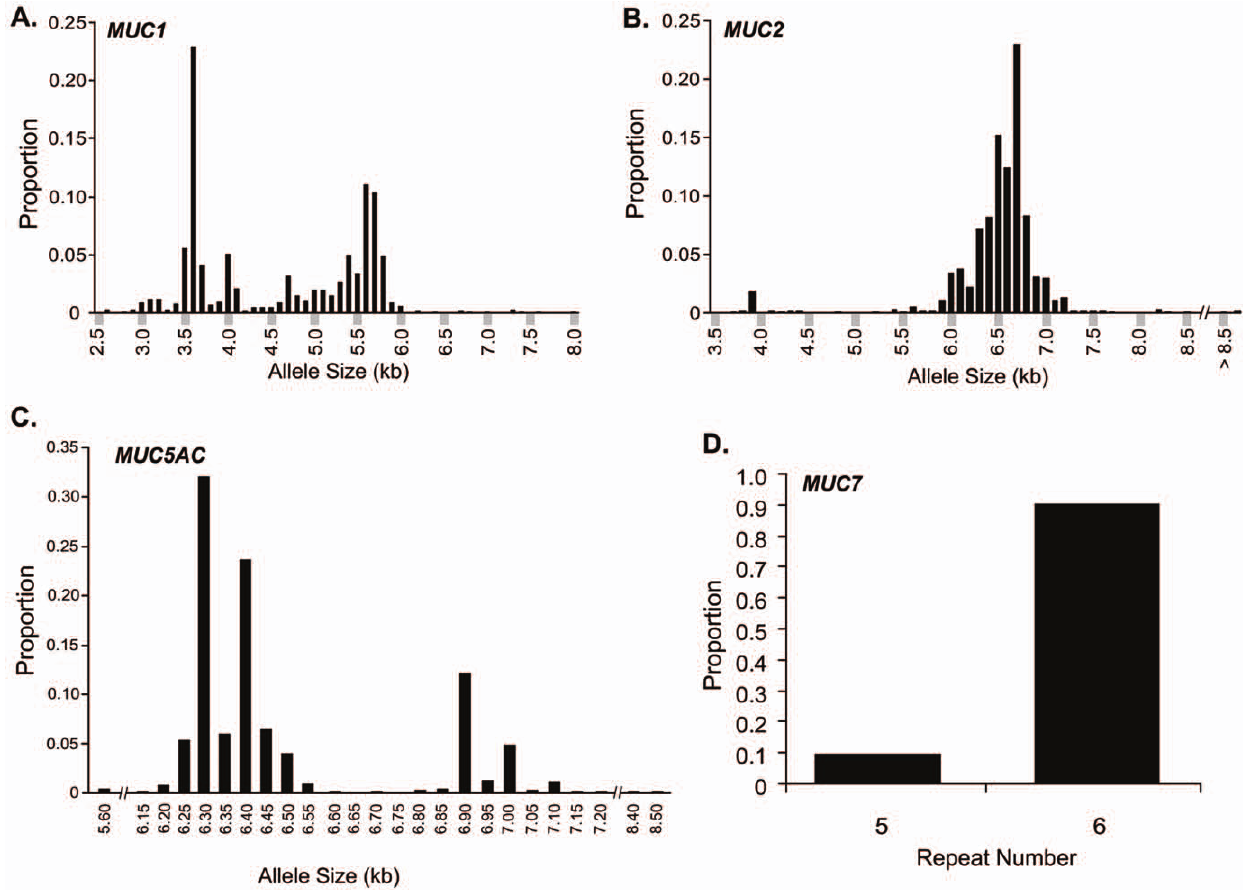
Figure 1. Distributions of VNTR allele sizes. Distributions of VNTR allele sizes as determined by Southern blot analysis of Hinf I-digested genomic DNA are shown for (A) MUC1 , (B) MUC2 , (C) MUC5AC, and by polymerase chain reaction for (D) MUC7 .